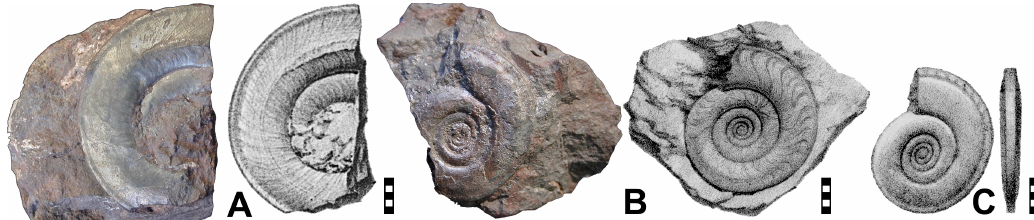
Fig. 21. Acanthoclymenia planorbis (Sandberger & Sandberger, 1851). A . Lectotype 46a in the